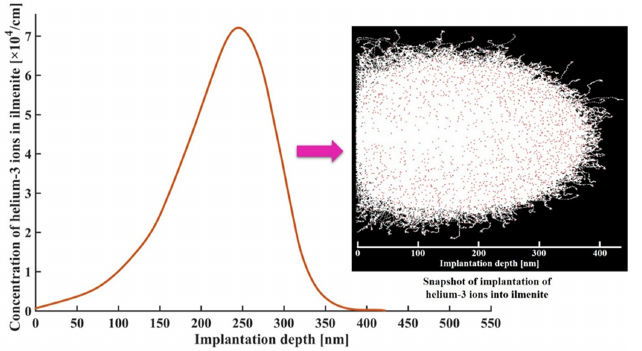
Figure 1. Concentration profile of implanted helium-3 ions in lunar ilmenite. The inset shows a snapshot of the implantation of helium-3 ions into